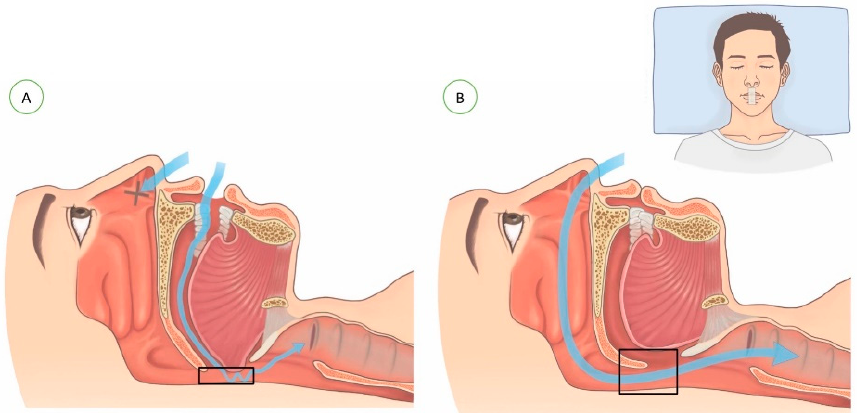
after Figure 1. Figures demonstrating the breathing routes of ( A ) mouth-breathing and ( B ) nasal-breath- ing after mouth-taping.